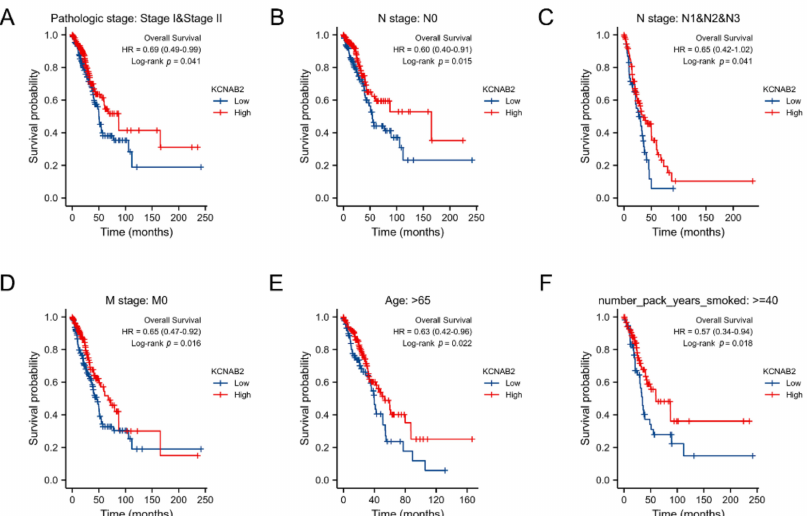
Figure 5. Associations between the expression of KCNAB2 and the overall survival based on LUAD patients with different clinical parameters. ( A ) Stage I–II, ( B ) N0, ( C ) N1–N3, ( D ) M0, ( E ) age over 65 years old, and ( F ) smoker over 40